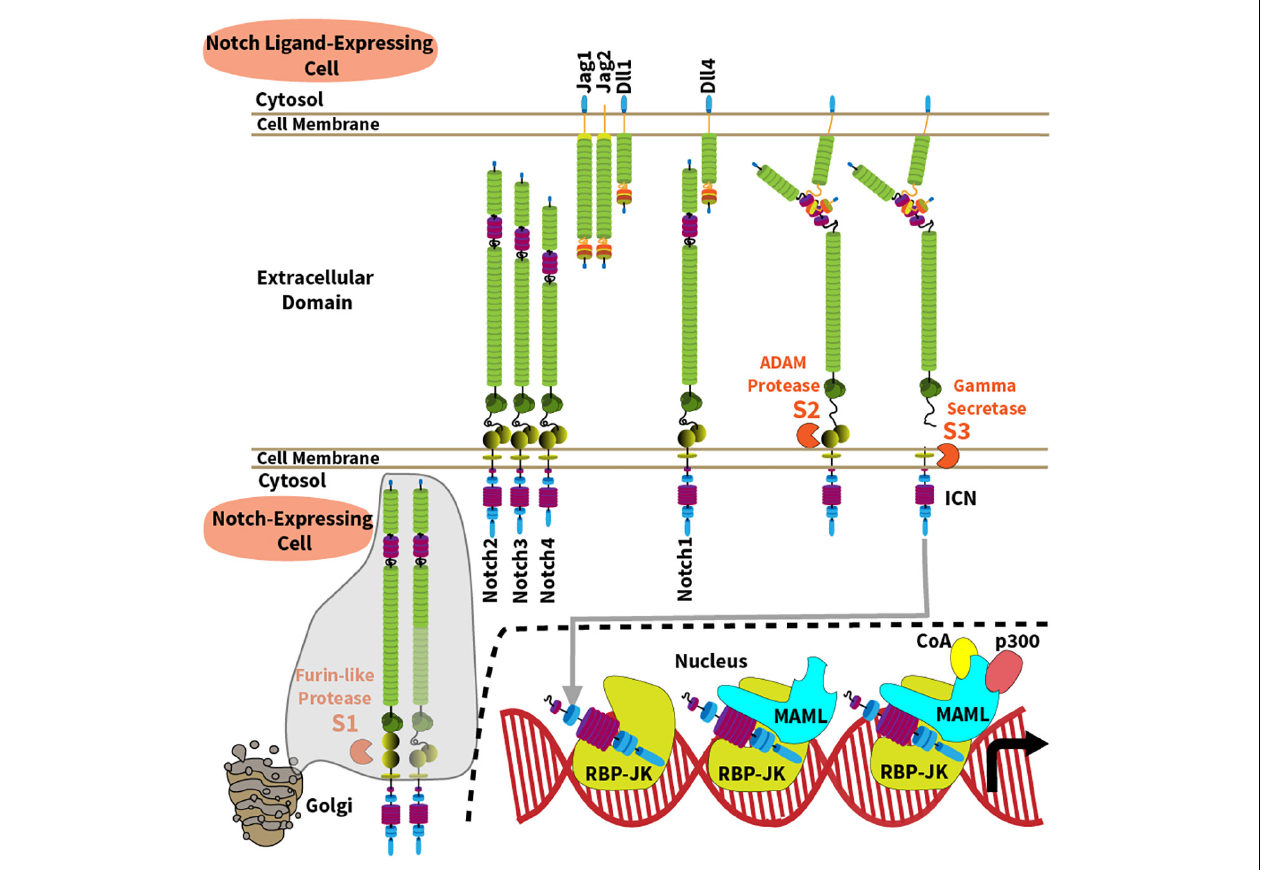
FIGURE 1 | Overview of the Notch signaling pathway. The Notch signaling pathway operates between four cell surface Notch receptors (Notch1-4) and four agonistic Notch ligands from the Jagged (Jag1, Jag2) and Delta-like families (Dll1, Dll4). Mechanisms of Notch activation and canonical signaling are depicted along the following steps: (1) A furin-like protease cleaves the Notch receptor into a transmembrane heterodimer during its transit to cell surface through the Golgi complex (S1 site); (2) Ligand-receptor binding generates a physical force onto the extracellular domain of the Notch receptor, allowing ADAM10-mediated proteolysis at the S2 site which is normally hidden within a “negative regulatory region” of the receptor; (3) ADAM10 generates a membrane-bound intermediate that becomes rapidly sensitive to intramembrane proteolysis by the γ -secretase complex (S3 site). As a result, intracellular Notch (ICN) is released into the cytoplasm and translocates into the nucleus. (4) ICN binds with the DNA-binding protein RBP-J κ (also known as CSL); (5) ICN and RBP-J κ recruit a member of the Mastermind-like (MAML) family of transcriptional coactivators via the N-terminal MAML alpha-helical domain; (6) In turn, MAML proteins recruit other transcriptional co-activators (CoA) and p300, respectively, to enhance transcription of Notch target